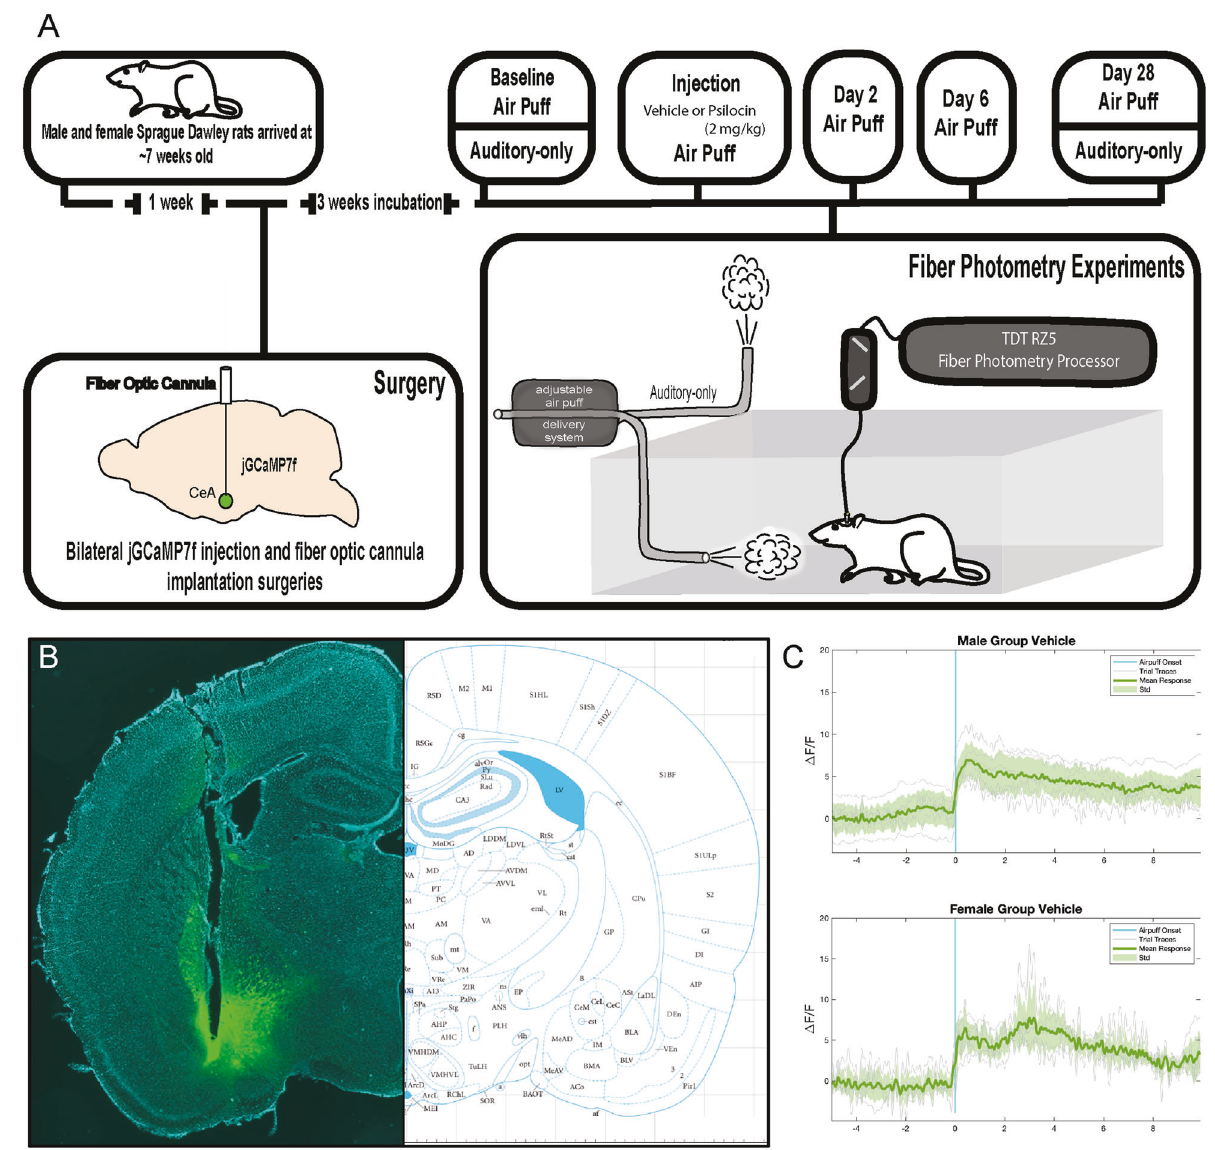
Fig. 1 Schematic including experimental timeline, representative coronal image, and group mean photometry traces. A Experimental timeline. Animals arrived at 6 – 7 weeks old and were allowed to habituate for 1 week prior to surgeries. Bilateral injection of calcium sensor (jGCaMP7f) and implantation of fi ber optic cannulas were conducted. After 3 weeks for viral transduction, animals underwent a series of fi ber photometry experiments. B Representative coronal section showing fi ber placement and GCaMP expression. C Mean air-puff traces showing consistency of CeA signal in response to the air-puff